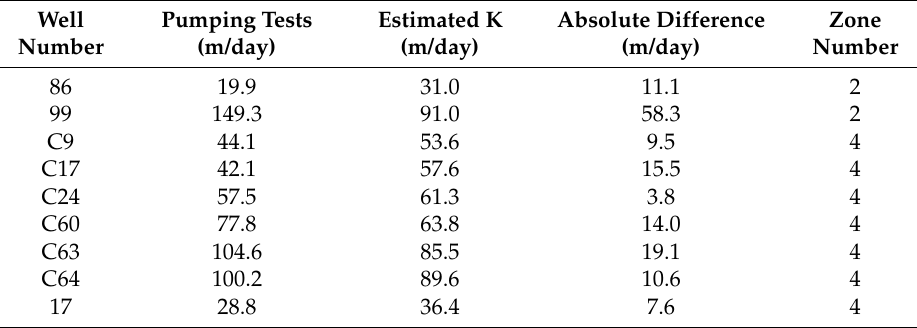
Table 3. Verification of the estimated hydraulic conductivity (K).